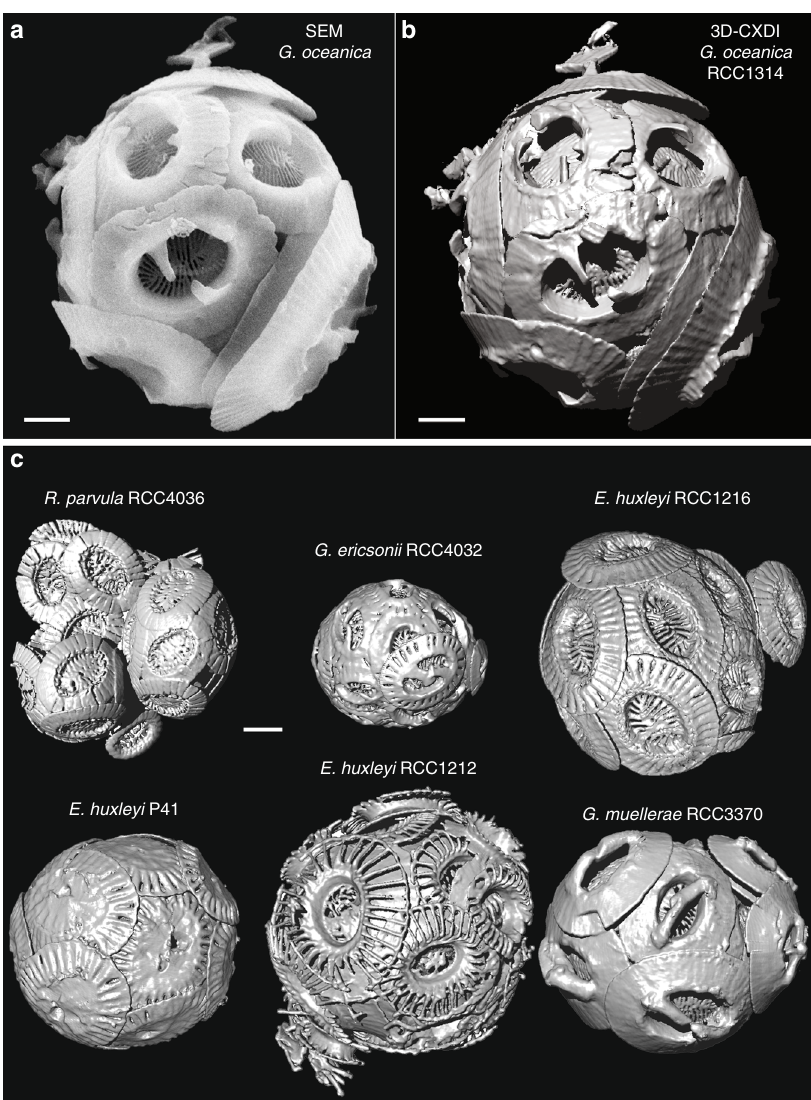
Fig. 1 3D-CXDI of coccospheres. a SEM image of G. oceanica RCC1314 . b 3D-CXDI view of G. oceanica RCC1314 . c 3D-CXDI views of six other coccospheres. Scale bar = 1 µ